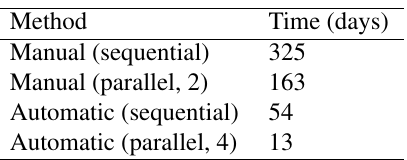
Table 1. Time needed to upgrade all